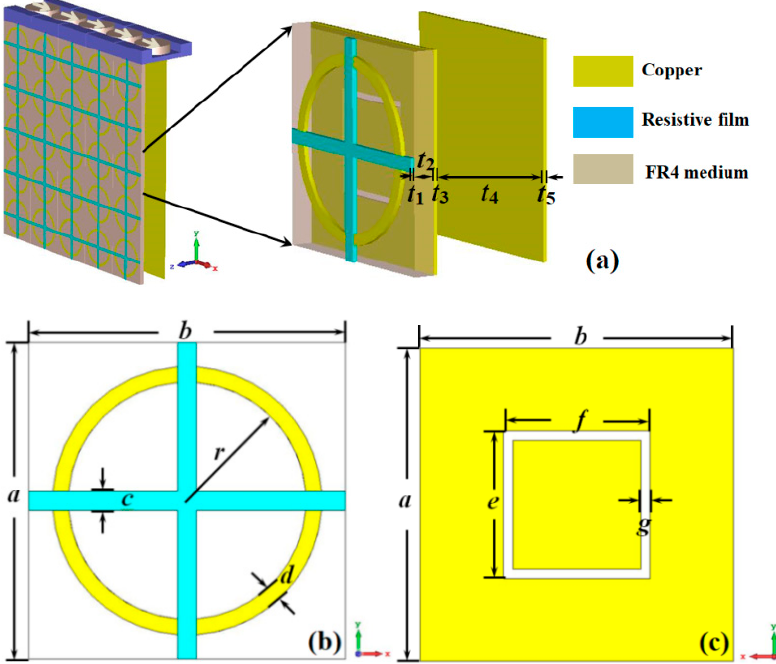
Figure 1. The diagram of the switchable rasorber/absorber: ( a ) perspective view; ( b ) front view; ( c ) back view.